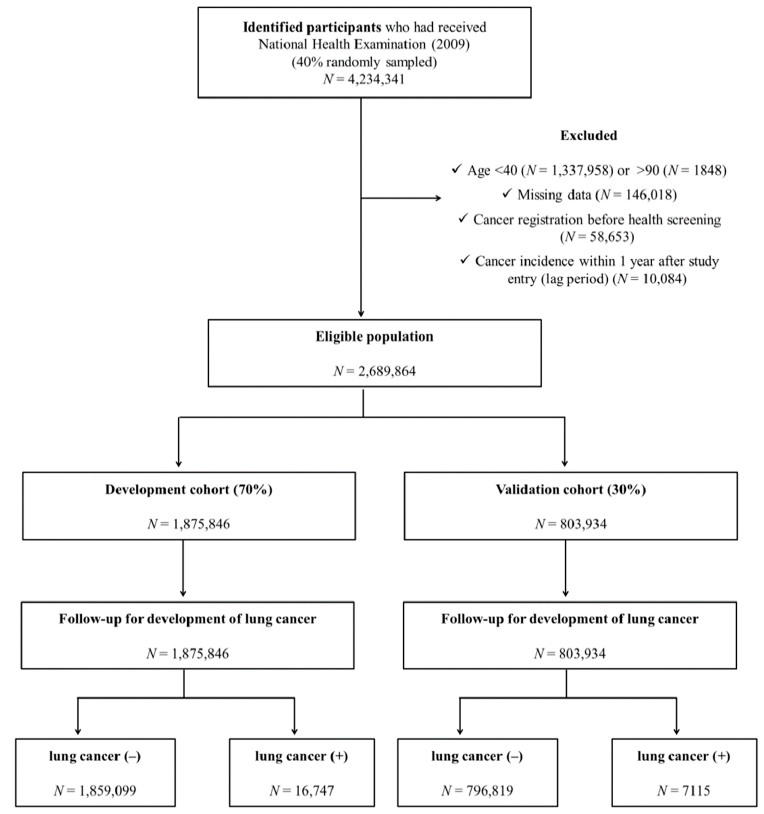
Figure 1. Study design summary.